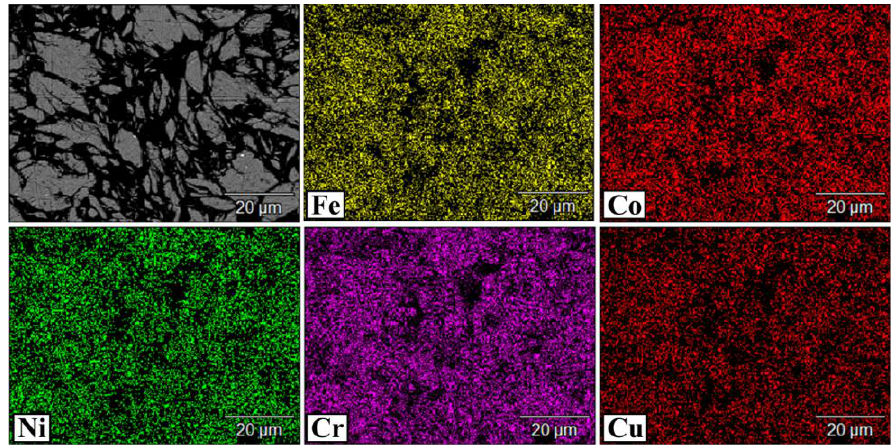
Figure 2. Element distribution map in the CoCrCuFeNi powder subjected to MA.